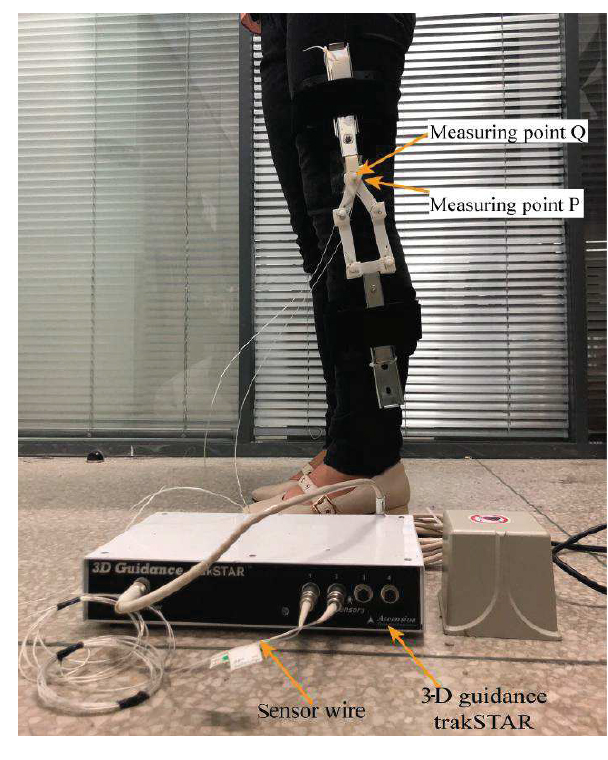
Figure 13. Motion experiment setup.